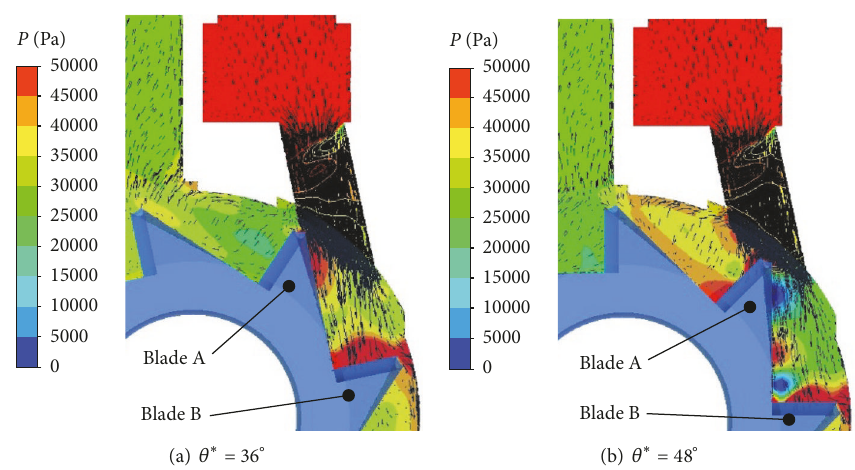
Figure 21: Static pressure distributions and absolute velocity vectors ( 𝑛 = 150 ,000 min −1 ).